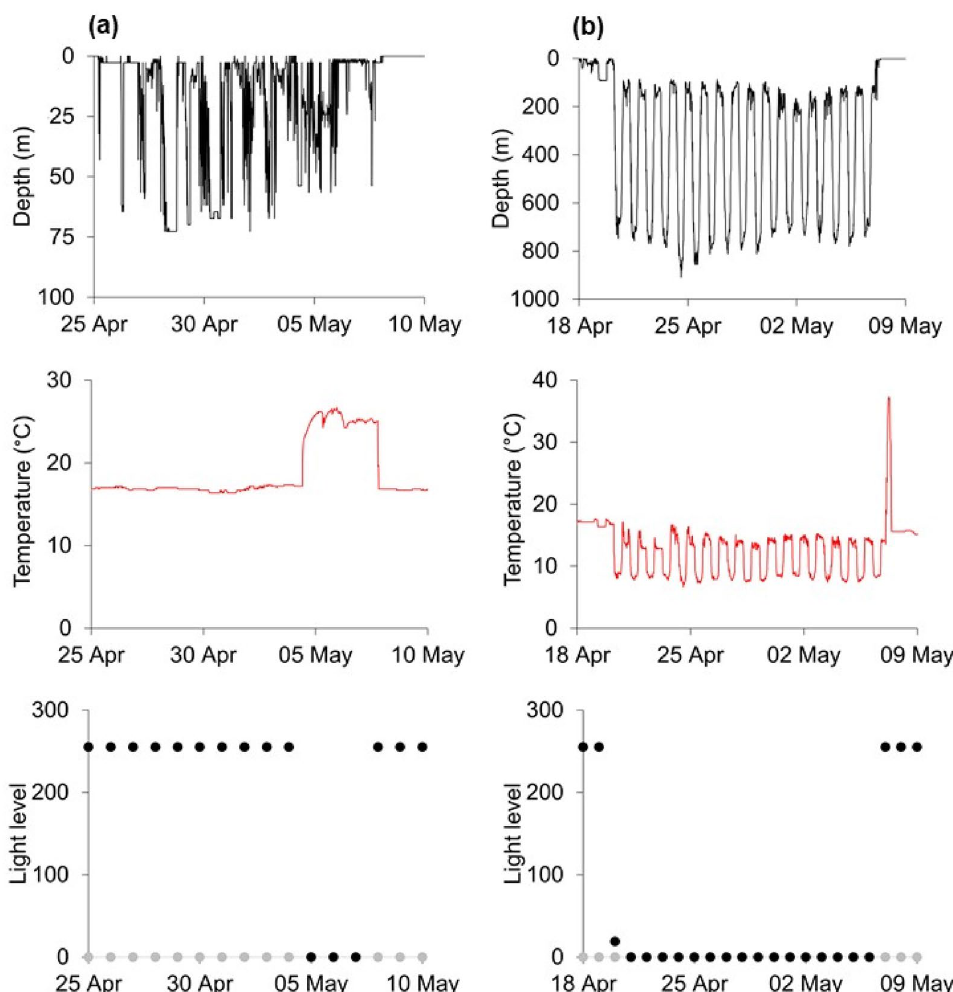
Figure 5. Examples of predation events for ( a ) eel 179386 in Bass Strait, showing a sudden temperature increase from ambient temperature to ~ 26 °C, indicative of a lamnid shark or a tuna, and ( b ) eel 179359 south of Tasmania, showing cessation of DVM behaviour during the day on 6 May 2019, at 150 m depth, and sudden temperature increase to approximately 37 °C, indicative of a marine mammal. Circles denote minimum (grey circle) and maximum (black circle) light level